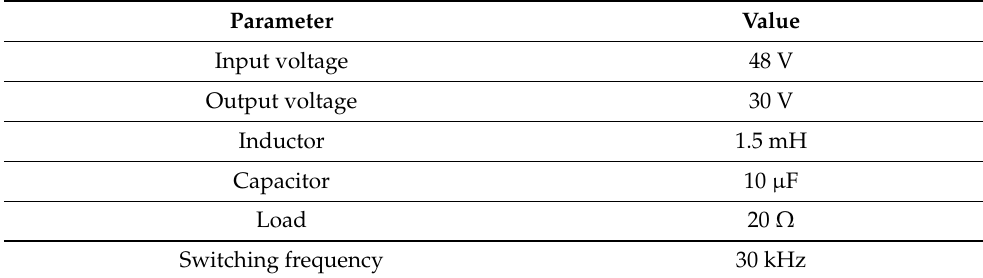
Table 1. Converter parameters.